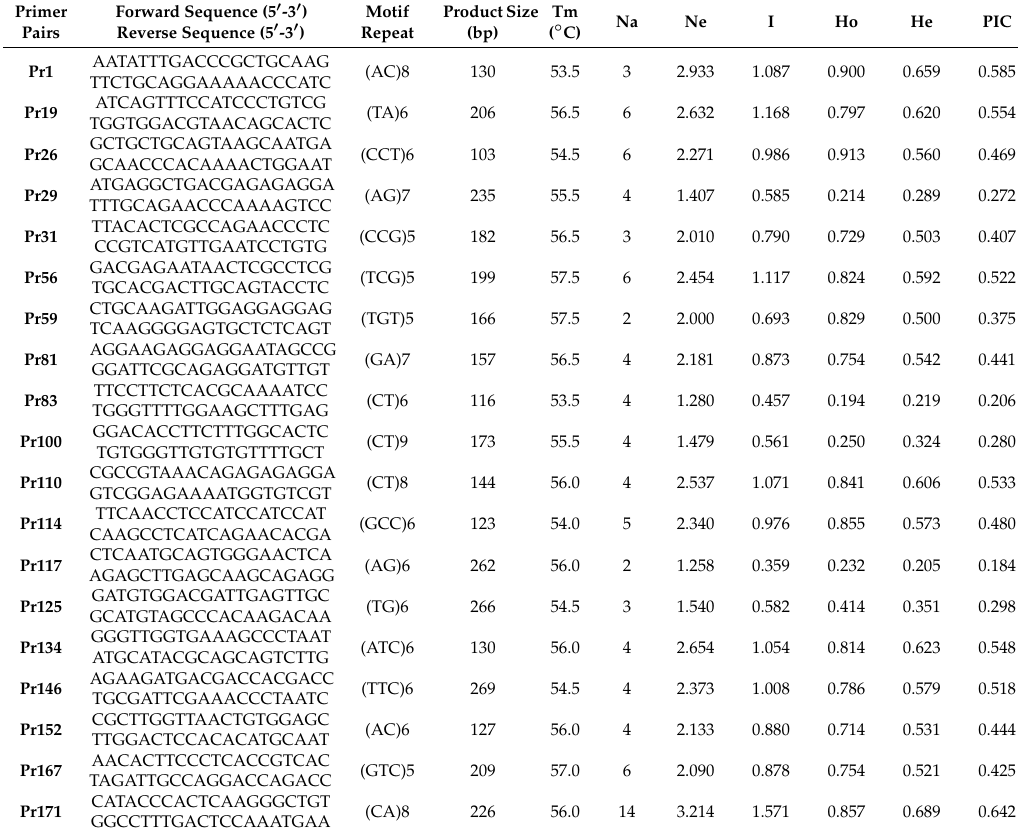
Figure 3. Details of the screening results of percentage for EST-SSR primer pairs. Table 2. Details of the 33 SSR primer pairs used and their summary of